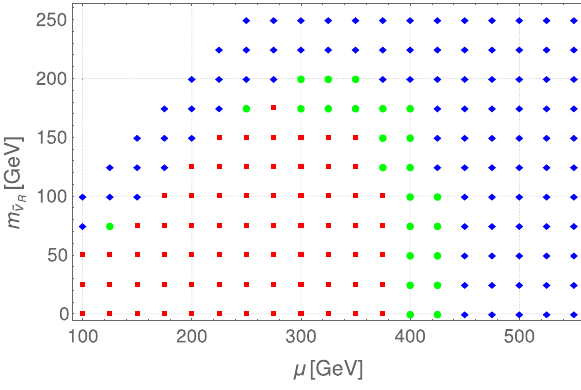
Fig. 6 Constraints on combinations of m ˜ ν production pp → ˜ χ + ˜ χ − → l + l − ˜ ν R ˜ ν ∗ Fig.